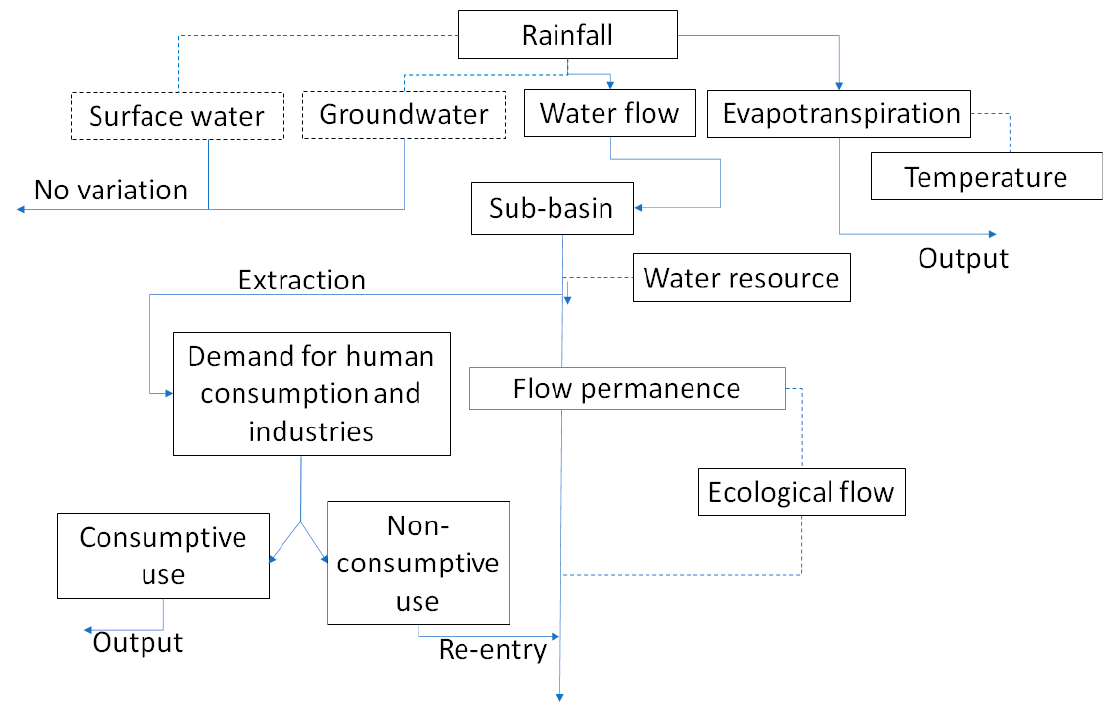
Figure 3. Flowchart contrasting offer and demand in the region.